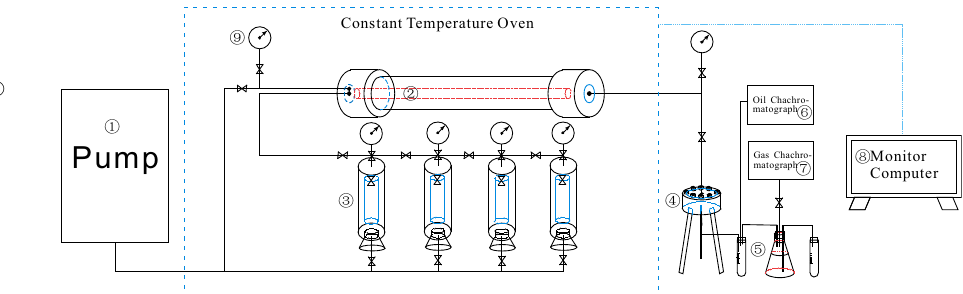
Fig. 2 Schematic diagram of